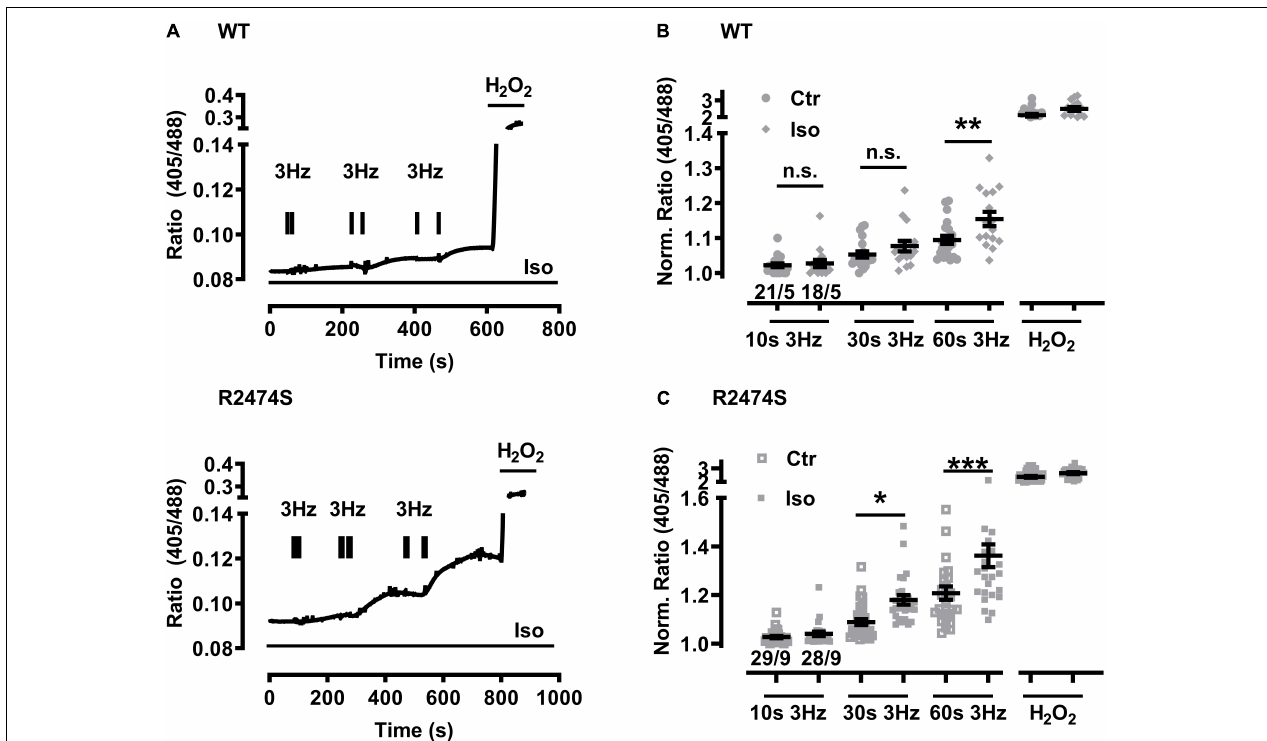
FIGURE 6 | Increased mitochondrial oxidation in WT control and RyR2-R2474S dTG-cardiomyocytes following β -adrenergic stimulation and 3 Hz beating. (A) Representative time course of the I405/I488 nm ratio of RyR2-WT control ( top ) and RyR2-R2474S dTG ( bottom )-cardiomyocytes upon/during isoproterenol (100 nM) stimulation. Black bar pairs indicate the start and stop of the pacing lasting 10, 30, or 60 s. H 2 O 2 (200 µ M) was added at the end of each experiment to obtain the maximal oxidized value. (B) Dot blot showing individual and mean values ± SEM of normalized ratio values obtained after EFS at 3 Hz with a 10, 30, and 60 s duration in the absence (open squares) or presence of isoproterenol (100 nM, closed squares) in cardiomyocytes from WT control mice. Numbers indicate the number of cells/number of mice used. Statistical analysis was performed by unpaired one-way ANOVA with Tukey’s post-test. ** P < 0.009; n.s., non-significant. (C) Dot plot summarizing the individual and mean ± SEM values of the normalized 405/488 nm ratio obtained following 3 Hz beating for 10, 30, and 60 s in the absence (open squares) and presence of isoproterenol (100 nM, closed squares) in RyR2-R2474S dTG-cardiomyocytes. Cell/heart numbers are indicated. Unpaired one-way ANOVA with Tukey’s post-test. *** P < 0.001; * p = 0.03; n.s.,